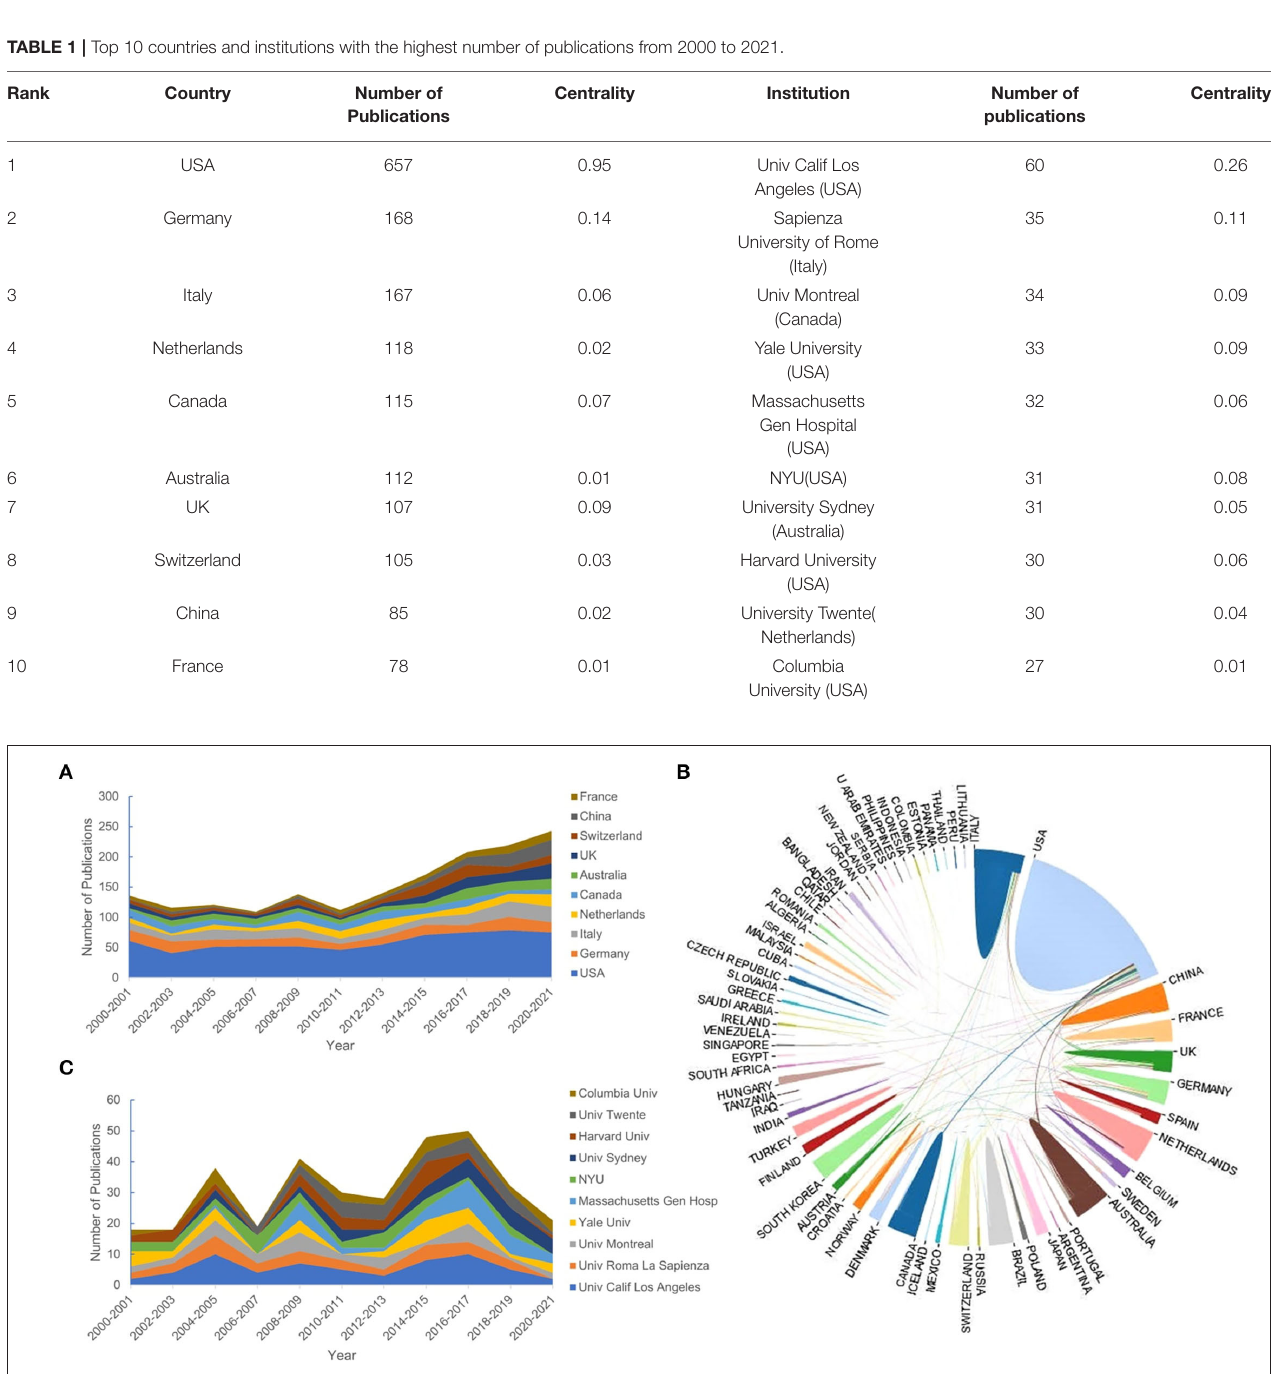
FIGURE 3 | The top 10 countries and institutions. (A) The number of publications of the top 10 countries. (B) The cooperative relationship between countries. (C) The number of publications of the top 10